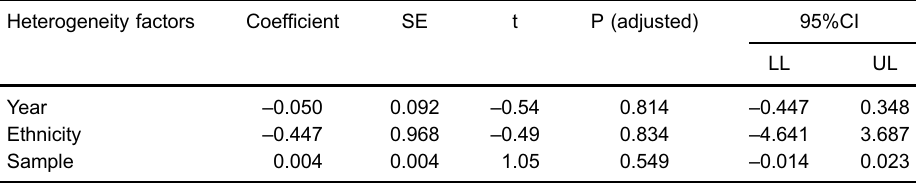
Table 3. Multi-factor regression analyses of the 5-year survival rate of gastric cancer (GC) patients based on the 9 included studies. Heterogeneity